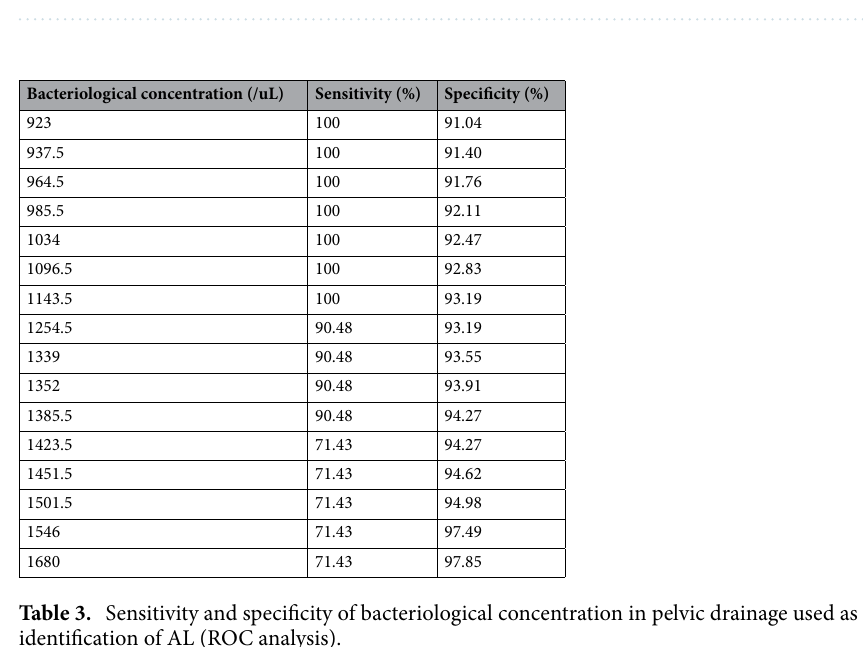
Table 3. Sensitivity and specificity of bacteriological concentration in pelvic drainage used as a cut-off in the identification of AL (ROC analysis).